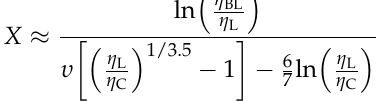
Figure 4. 10 This is a figure, Schemes follow the same formatting. If there are multiple panels, they should be listed as: ( a ) Description of what is contained in the first panel. ( b ) Description of what is contained in the second panel. Figures should be placed in the main text near to the first time they are cited. A caption on a single line should be centered.